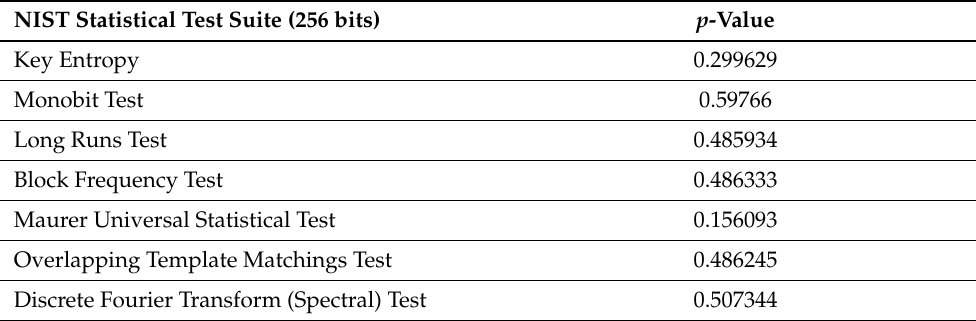
Table 3. Statistical randomness analysis of the extracted